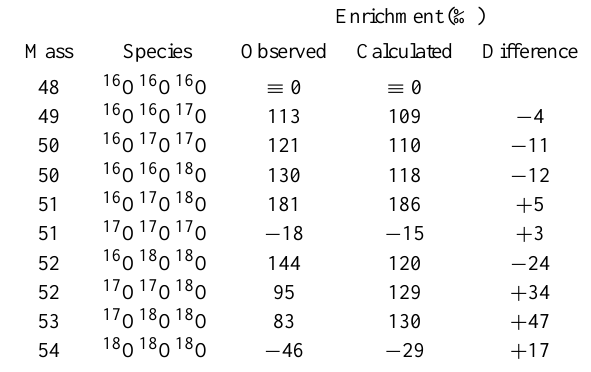
Table 1. Comparison between observed and calculated isotopic fractionation in ozone isotopomer (expressed in per mil) produced by photolysis. Data are from Mauersberger et al. (1993). The pa- rameters of the calculation are defined in Sect. 4.3. Parameters: